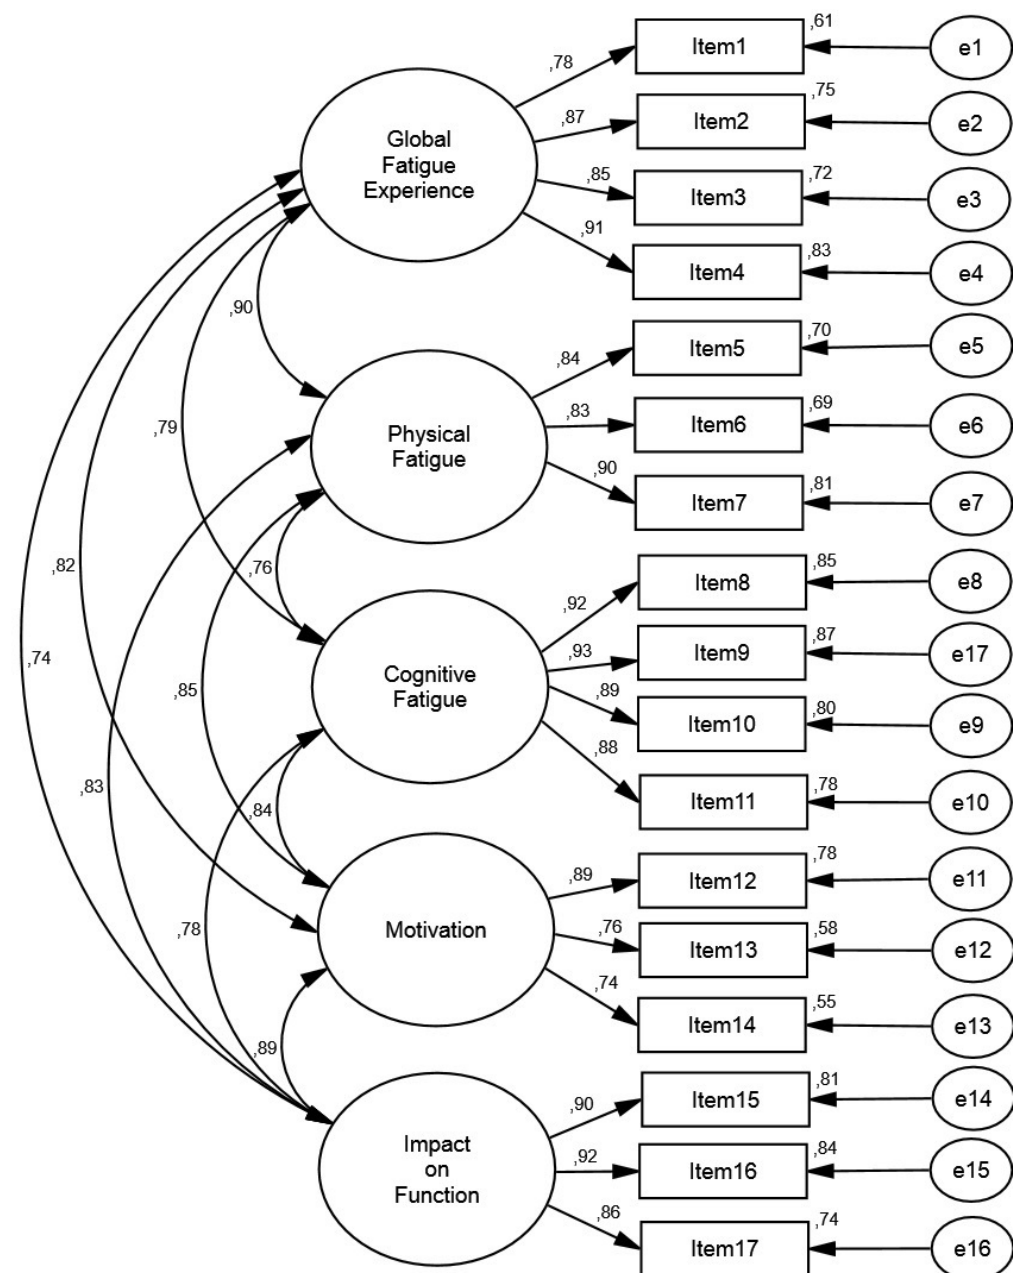
Figure 2. Measurement model in the Brazilian sample.